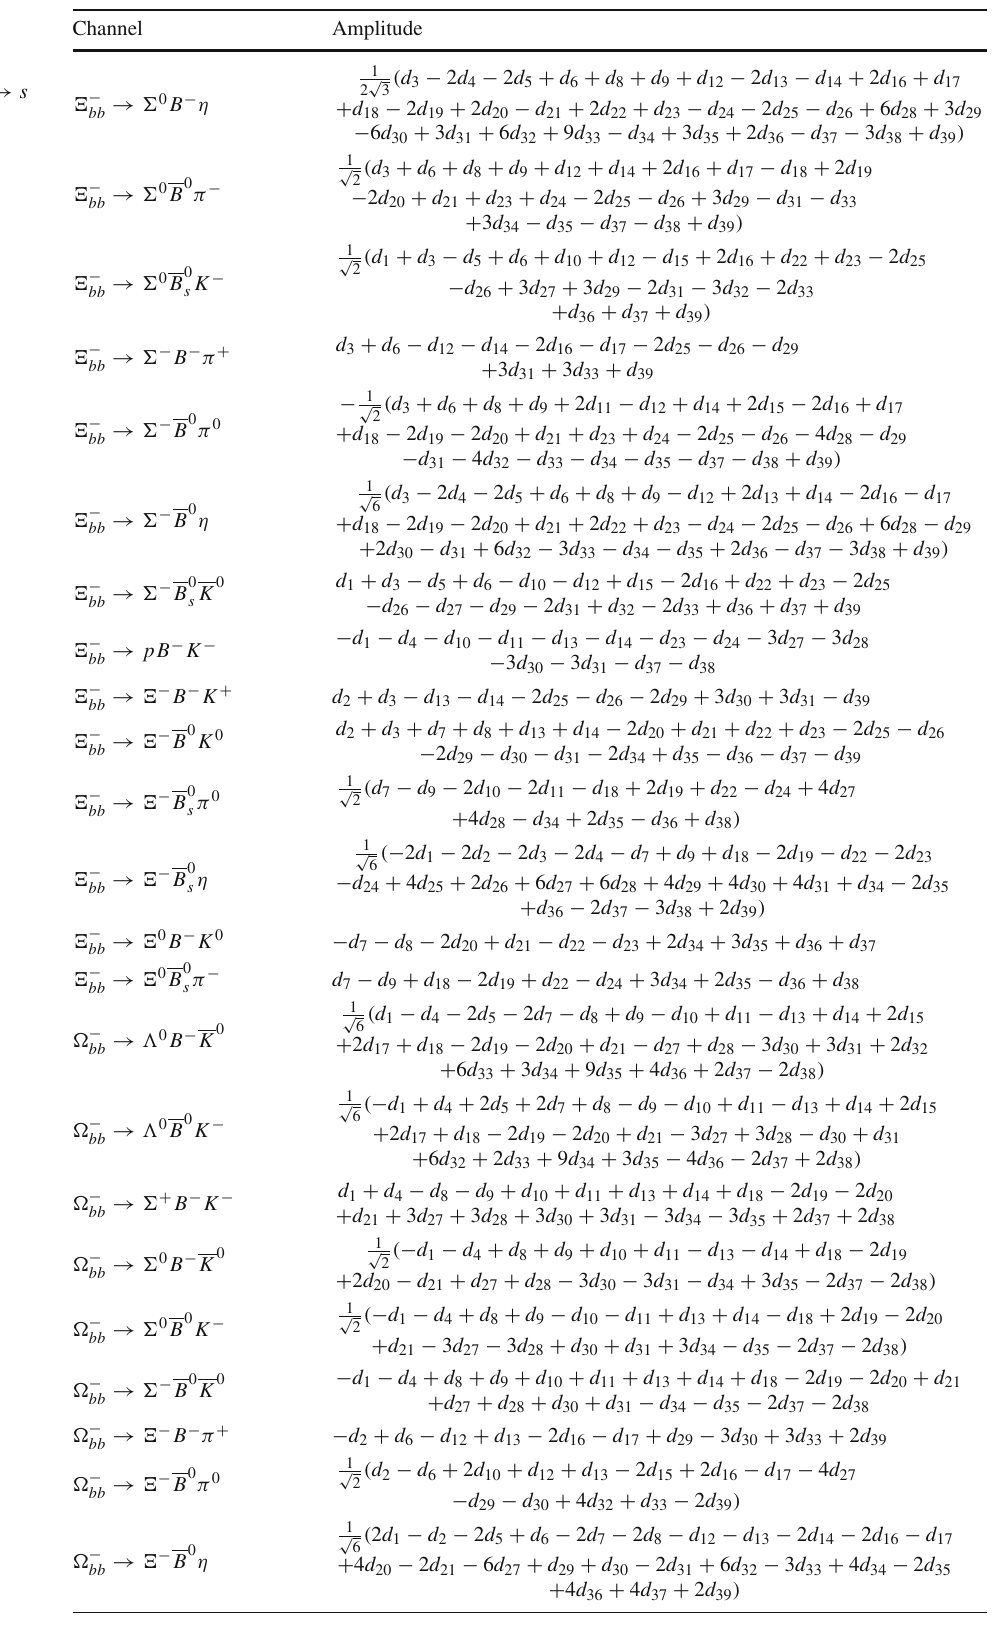
Table 31 Doubly bottom baryon decays into a bottom meson, a light baryon(8) induced by the charmless b → s transition and a light